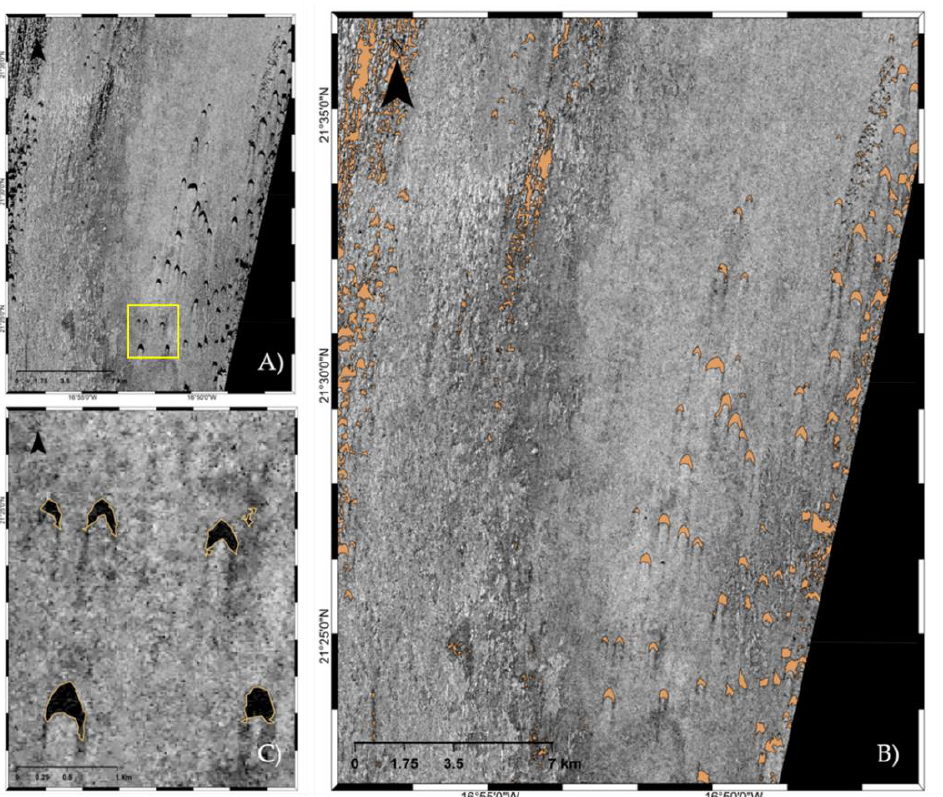
Figure 10. West Sahara dunes detected for 2003. ( A ) Subset of the SAR image covering the dune field. ( B ) SAR image overlaid with the detected sand bodies in orange. ( C ) Zoom showing SAR image in the yellow rectangle in Figure ( A ) as a background overlaid with the contour of the dunes in orange.